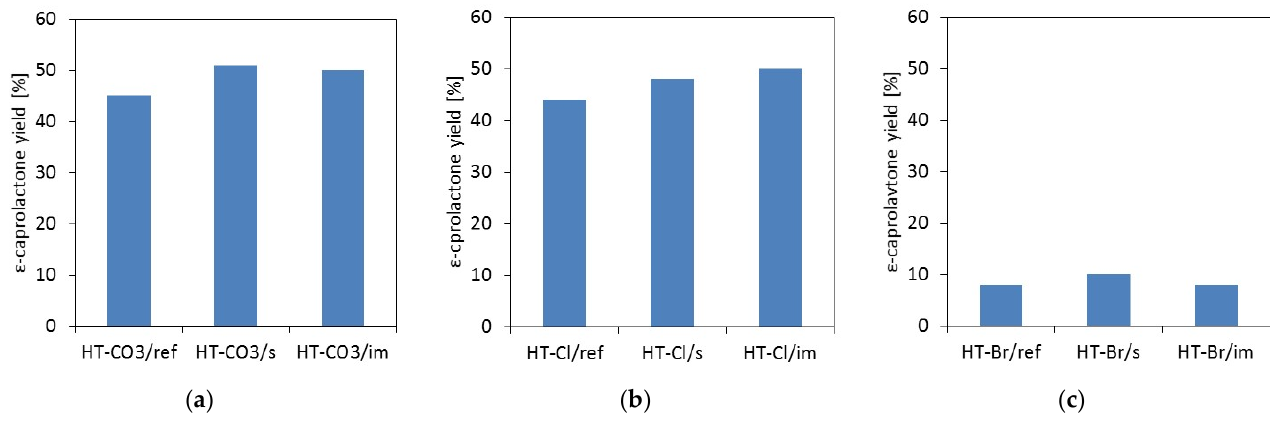
Figure 8. Yield of ε -caprolactone in HT materials in reaction medium alkalized with NaHCO 3 : ( a ) carbonate forms; ( b ) chloride forms; ( c ) bromide forms.